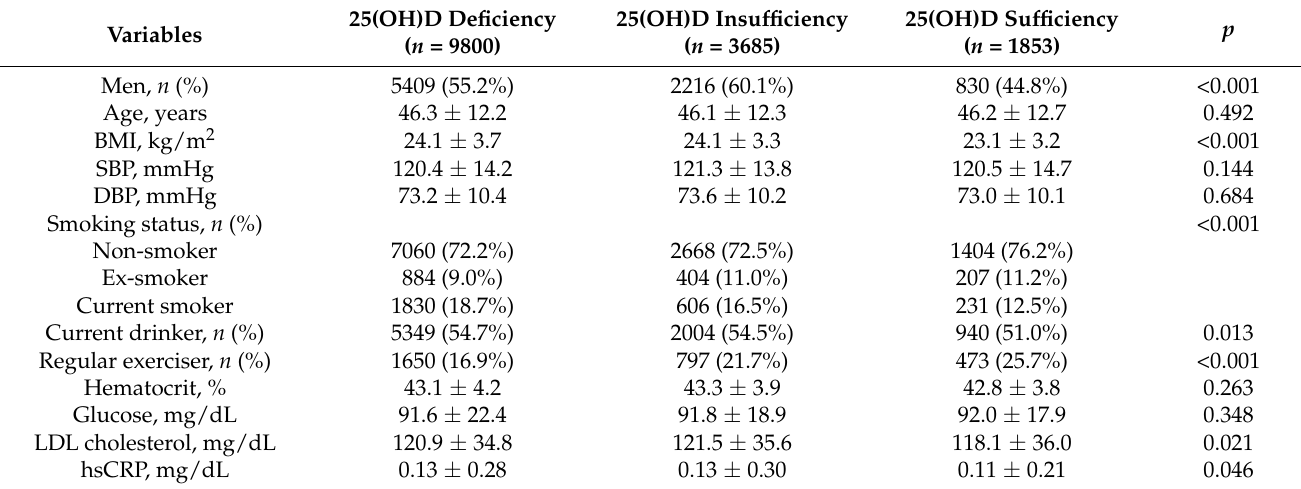
Table 1. Clinical characteristics of the study